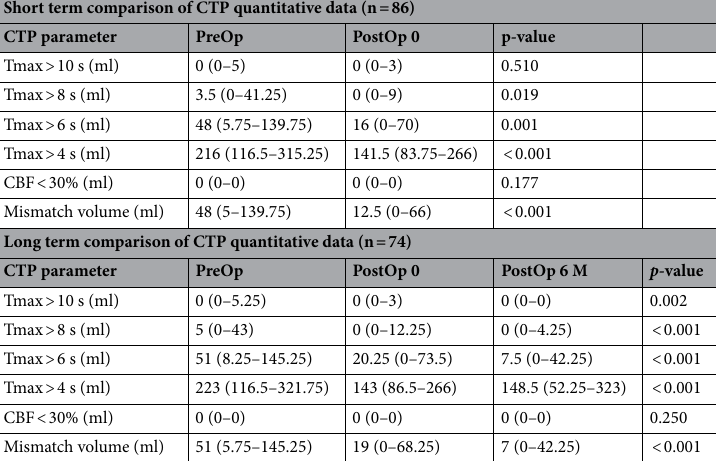
Table 2. Short- and long-term comparison of CTP data (median (interquartile)). CBF, cerebral blood flow; CTP, perfusion computed tomography; preOp, preoperative; postOp 0, immediate postoperative; postOp 6 M, postoperative 6 months; Tmax,